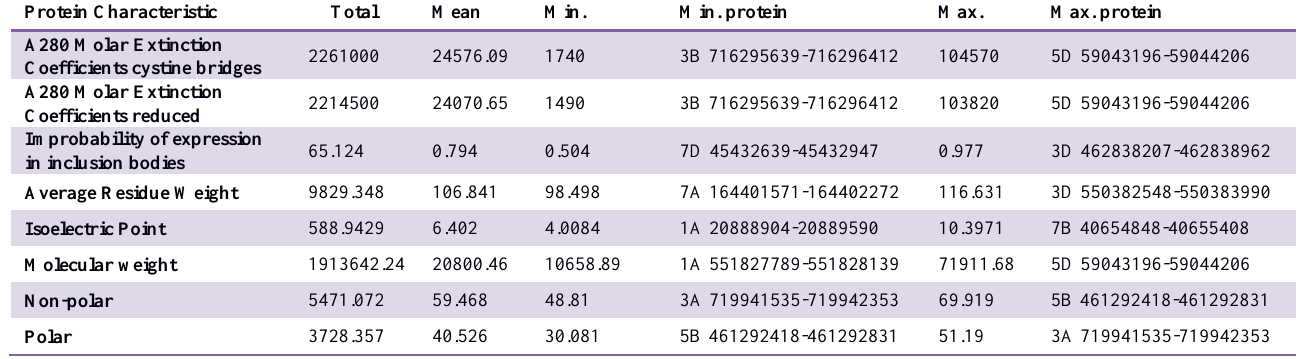
Table 1: The highest and lowest proteins characteristics and their corresponding proteins. Protein